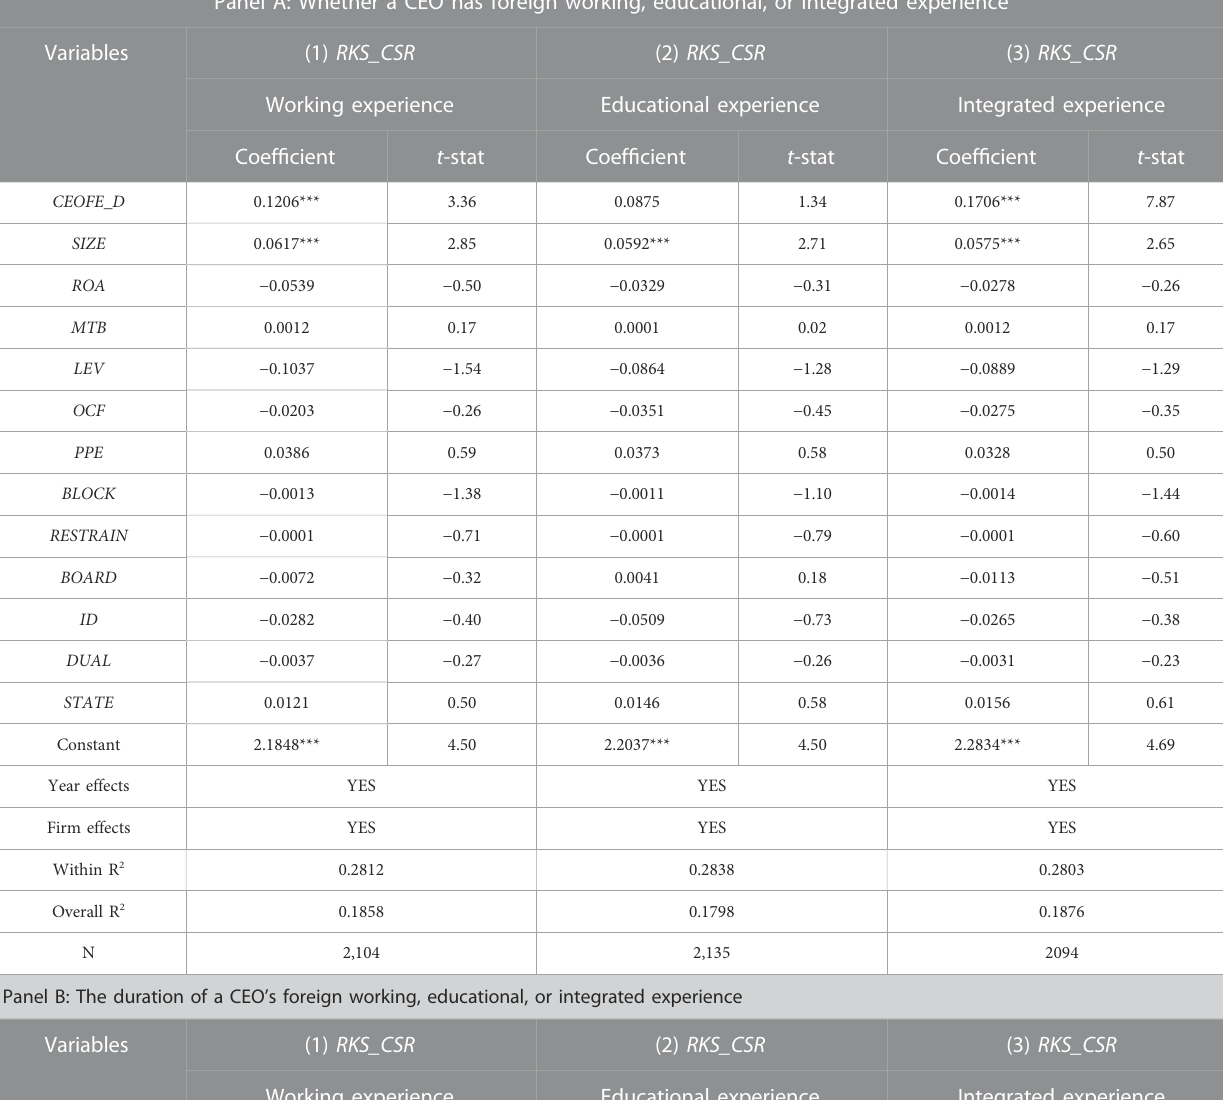
TABLE 10 CEO ’ s foreign experience and CSR (Different categories of foreign experience). Panel A: Whether a CEO has foreign working, educational, or integrated